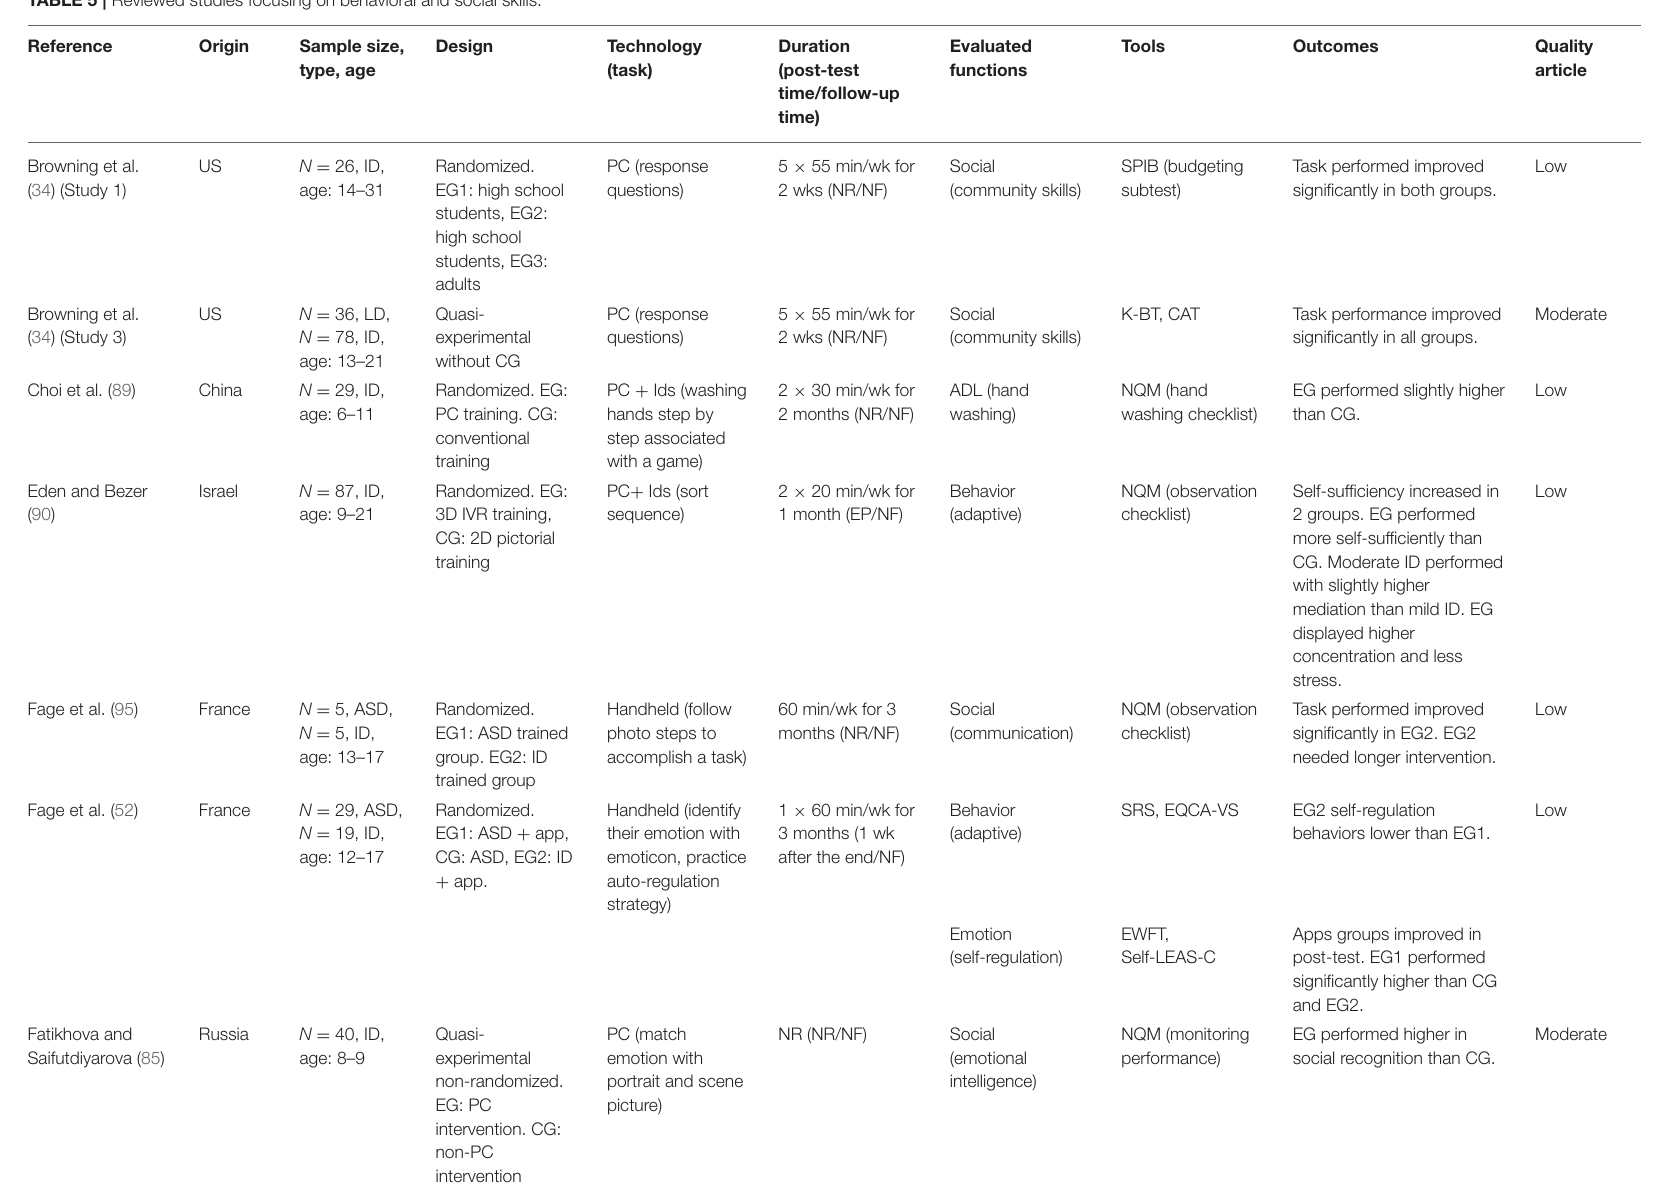
TABLE 5 | Reviewed studies focusing on behavioral and social